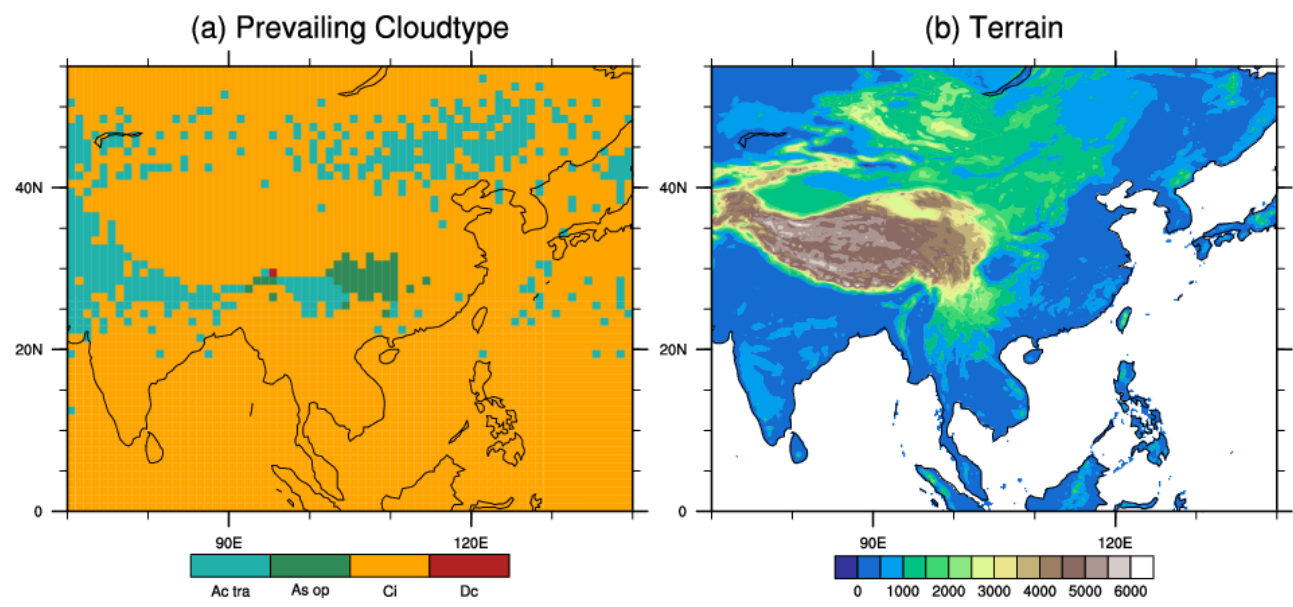
Figure 2. ( a ) Horizontal distribution of prevailing cloud types throughout the year. ( b ) The terrain of the East Asia continent.